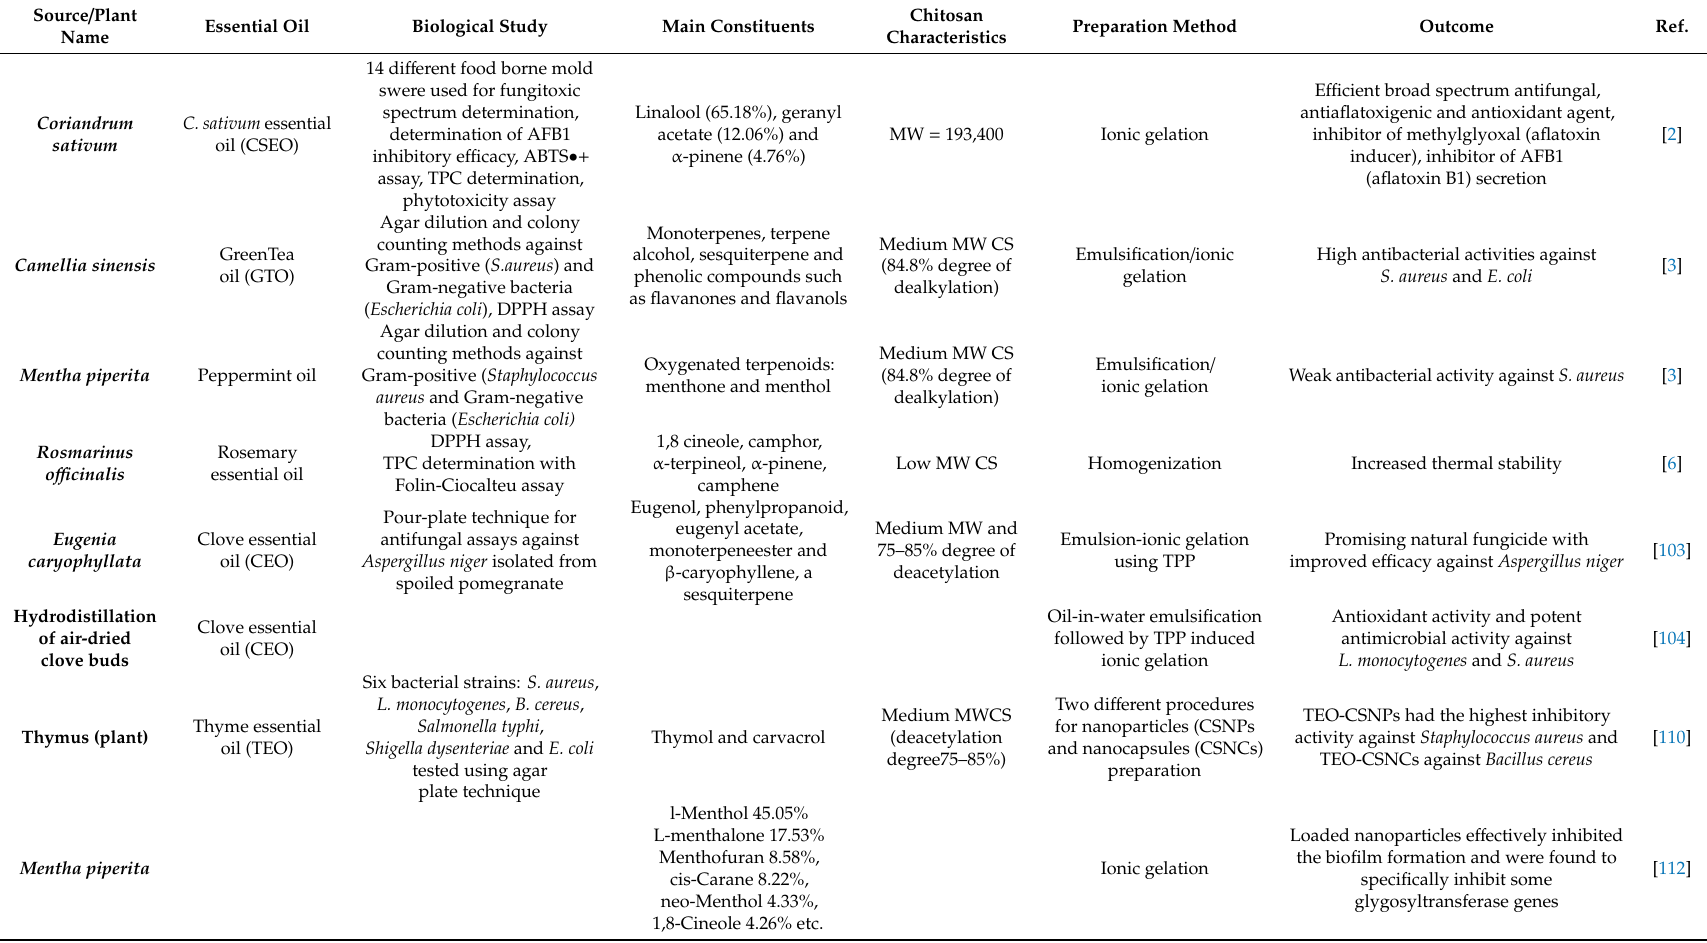
Table 2. Chitosan nanoparticles loaded with essential